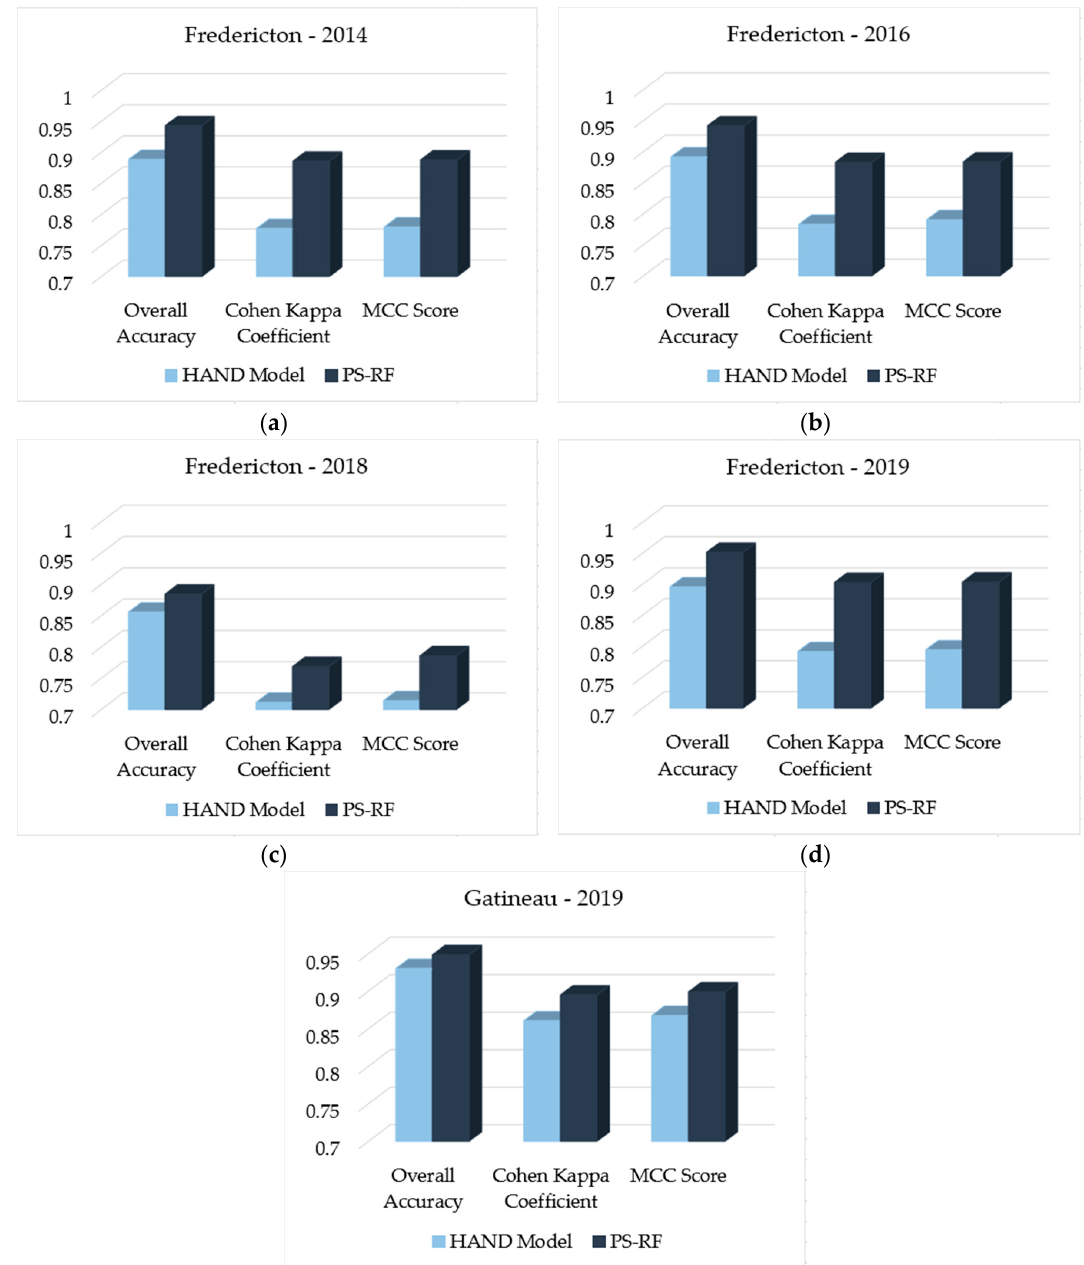
Figure 9. Overall Accuracy, Cohen’s Kappa Coefficient and Matthews Correlation Coefficient (MCC) Score for the HAND model and PS-RF in five flood events of ( a ) Fredericton 2014, ( b ) Fredericton 2016, ( c ) Fredericton 2018, ( d ) Fredericton 2019, and ( e ) Gatineau 2019.